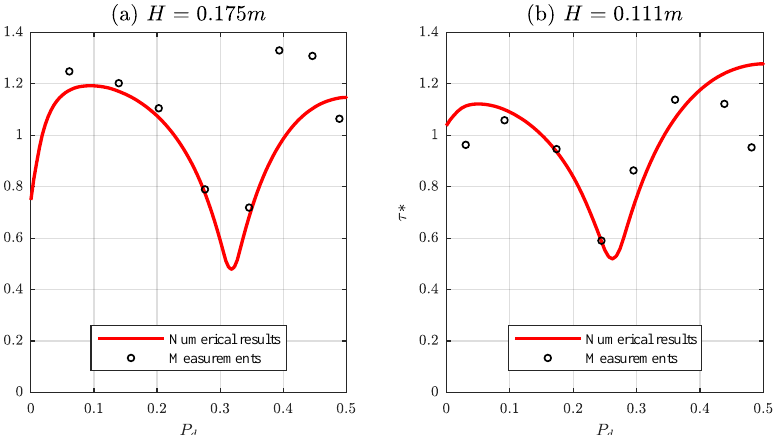
Figure 13. Comparison of calculated and measured boundary shear stress distributions in a rectangular channel of the experiments of Ghosh and Roy [34]: ( a ) H = 0.175 m; and ( b ) H = 0.111 m.